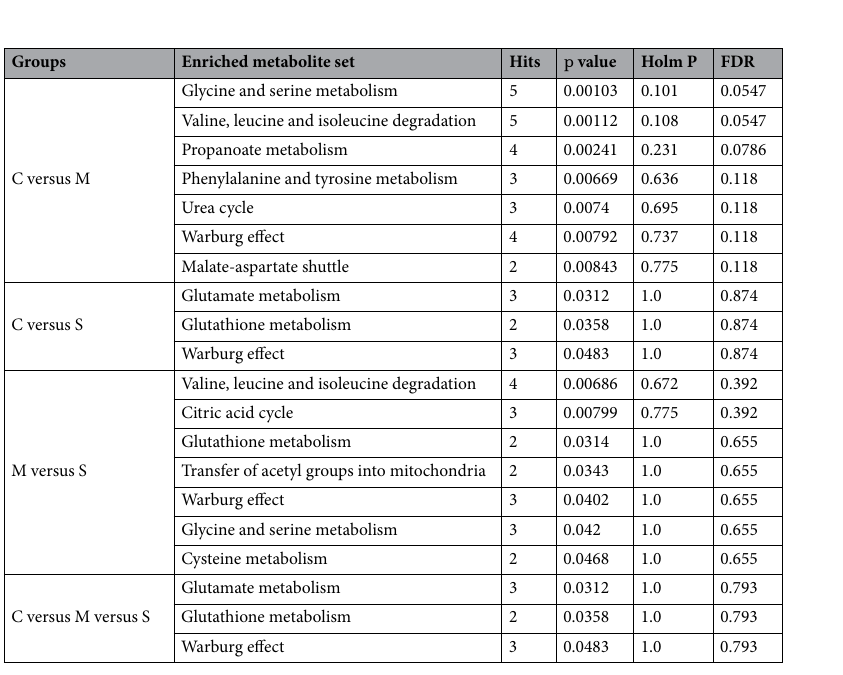
Table 4. Enriched pathway analysis identified in COVID19 patients. Results of the enrichment pathways according to Metaboanalyst (v4.0), employing the VIP values from PLS-DA analysis as the input metabolites.